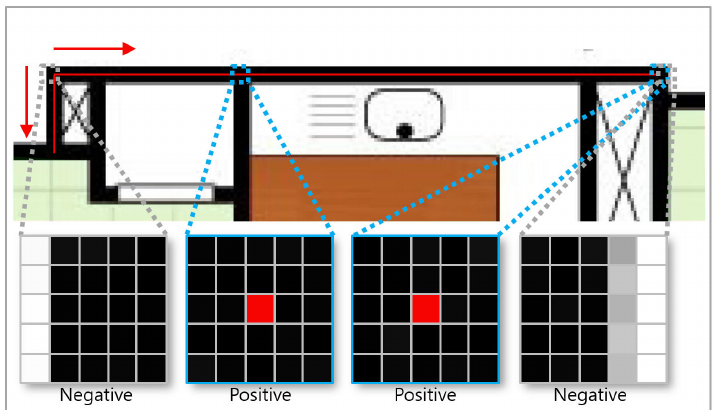
Figure 2. Restoring the wall center line using the moving kernel method.